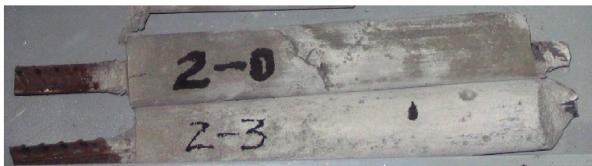
Figure 6: Surface statuses of the grouting body.